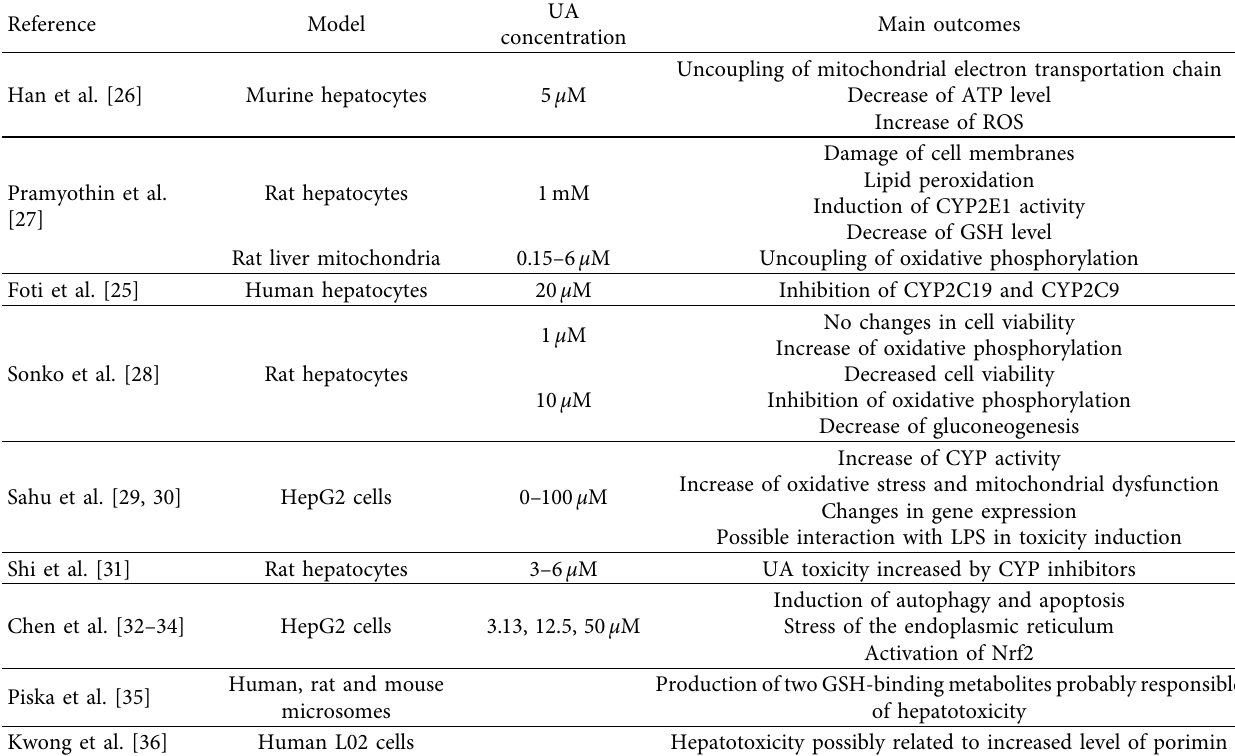
Table 1: Main outcomes of the in vitro studies on UA